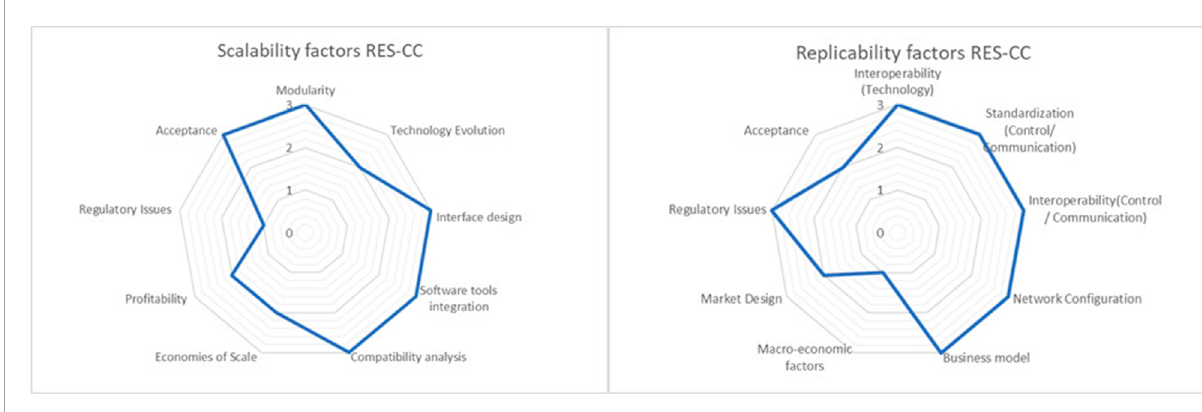
FIGURE 3 Spider graph on RES-CC scalability and replicability assessments.